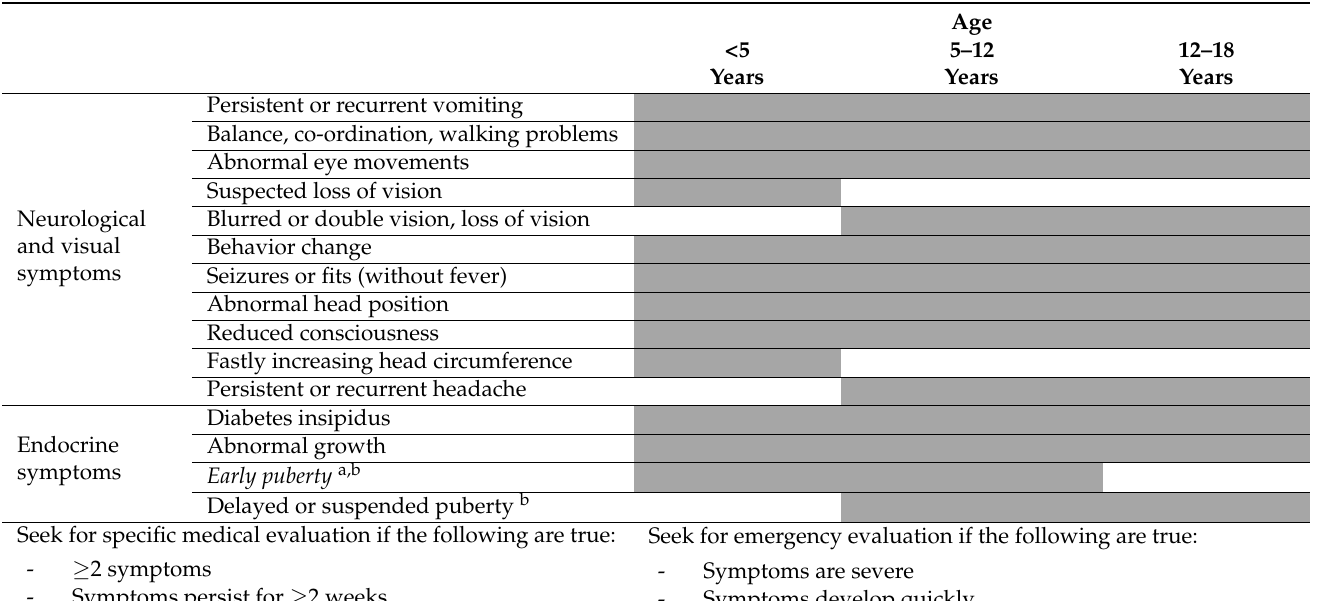
Table 1. Typical symptoms for each age group for which care givers and medical personal should seek medical evaluation, adapted from www.headsmart.org.uk (accessed on 8 July 2022)